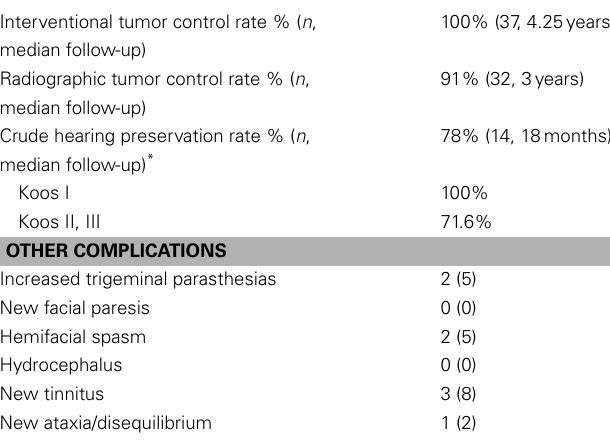
Table 3 |Treatment